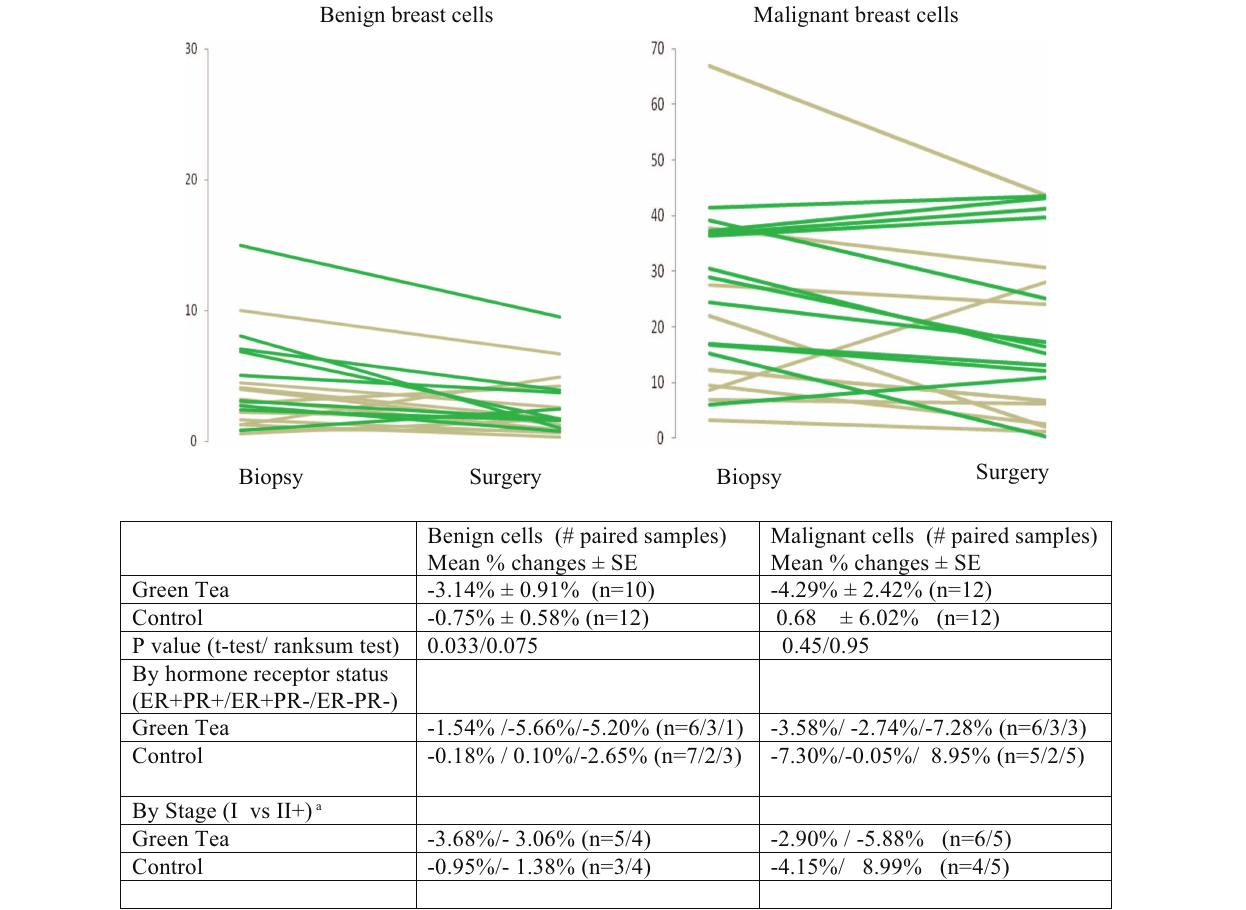
FIGURE 2 | Mean percent changes ( ± standard error of means) in quantitative Ki-67 immunohistochemical staining between diagnostic core biopsy and surgical specimens (green lines for green tea; gray lines for control); all subjects and by hormone receptor status and stage at diagnosis